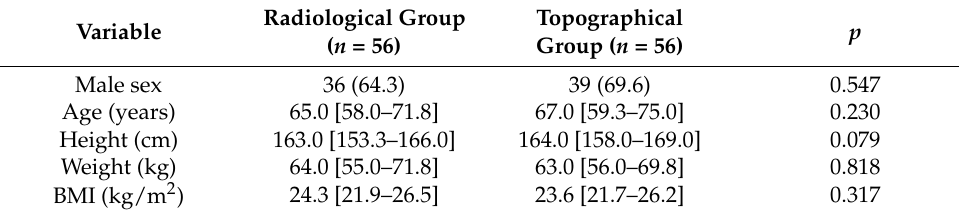
Table 1. Baseline characteristics of study participants.